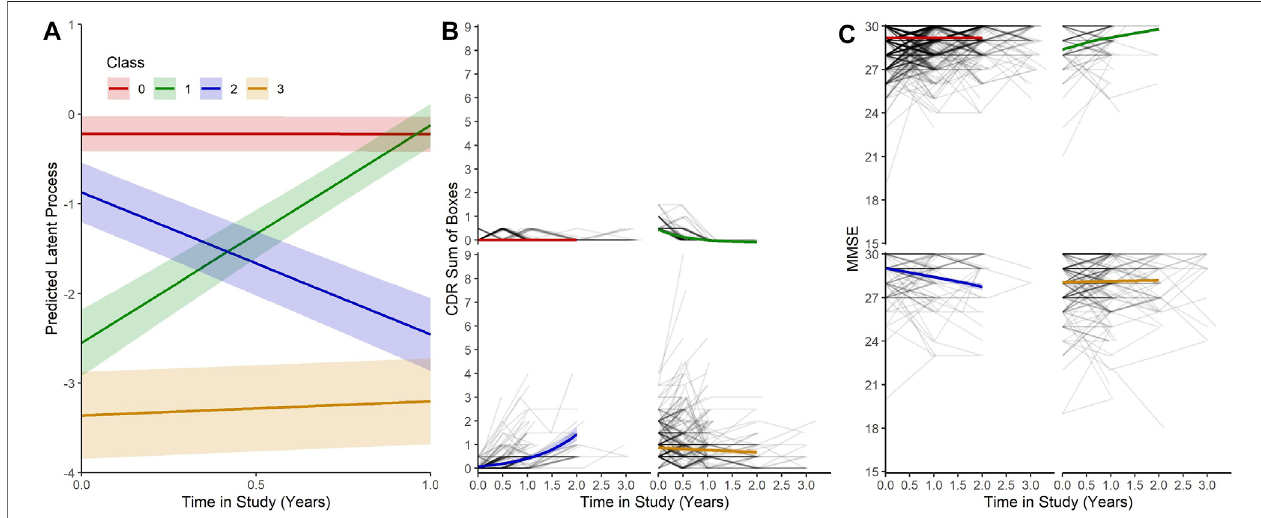
FIGURE 2 | (A) Predicted trajectories with 95% con fi dence bands for each class on the latent process scale given mean values for each of the covariates. (B) and (C) Predicted trajectories with 95% con fi dence bands for each class on the CDRSB and MMSE scale given mean values for the each of the covariates with observed outcomes for each participant.